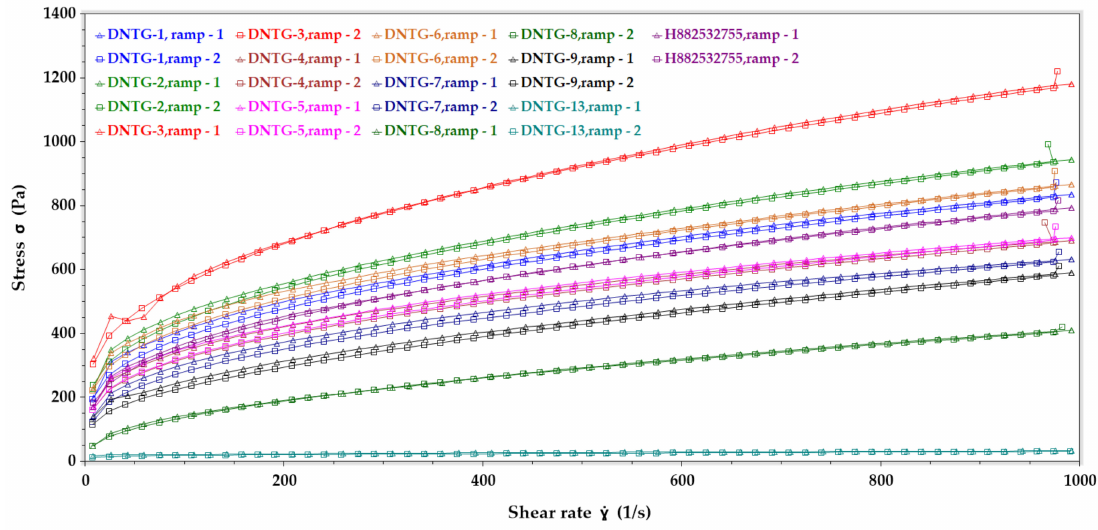
Figure 3. Flow curve (upward and downward curve) rheological data comparison between DNTG-1 to DNTG-9, DNTG-13 (niosomal gel), and H882532755 (reference